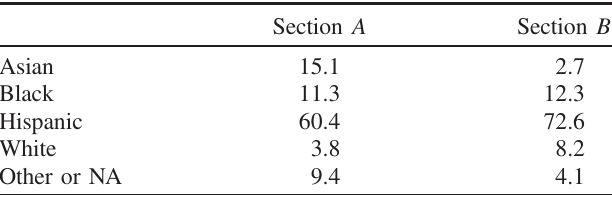
TABLE I. Students ’ ethnicity distributions. The numbers re- present the percentage of students in a given group.